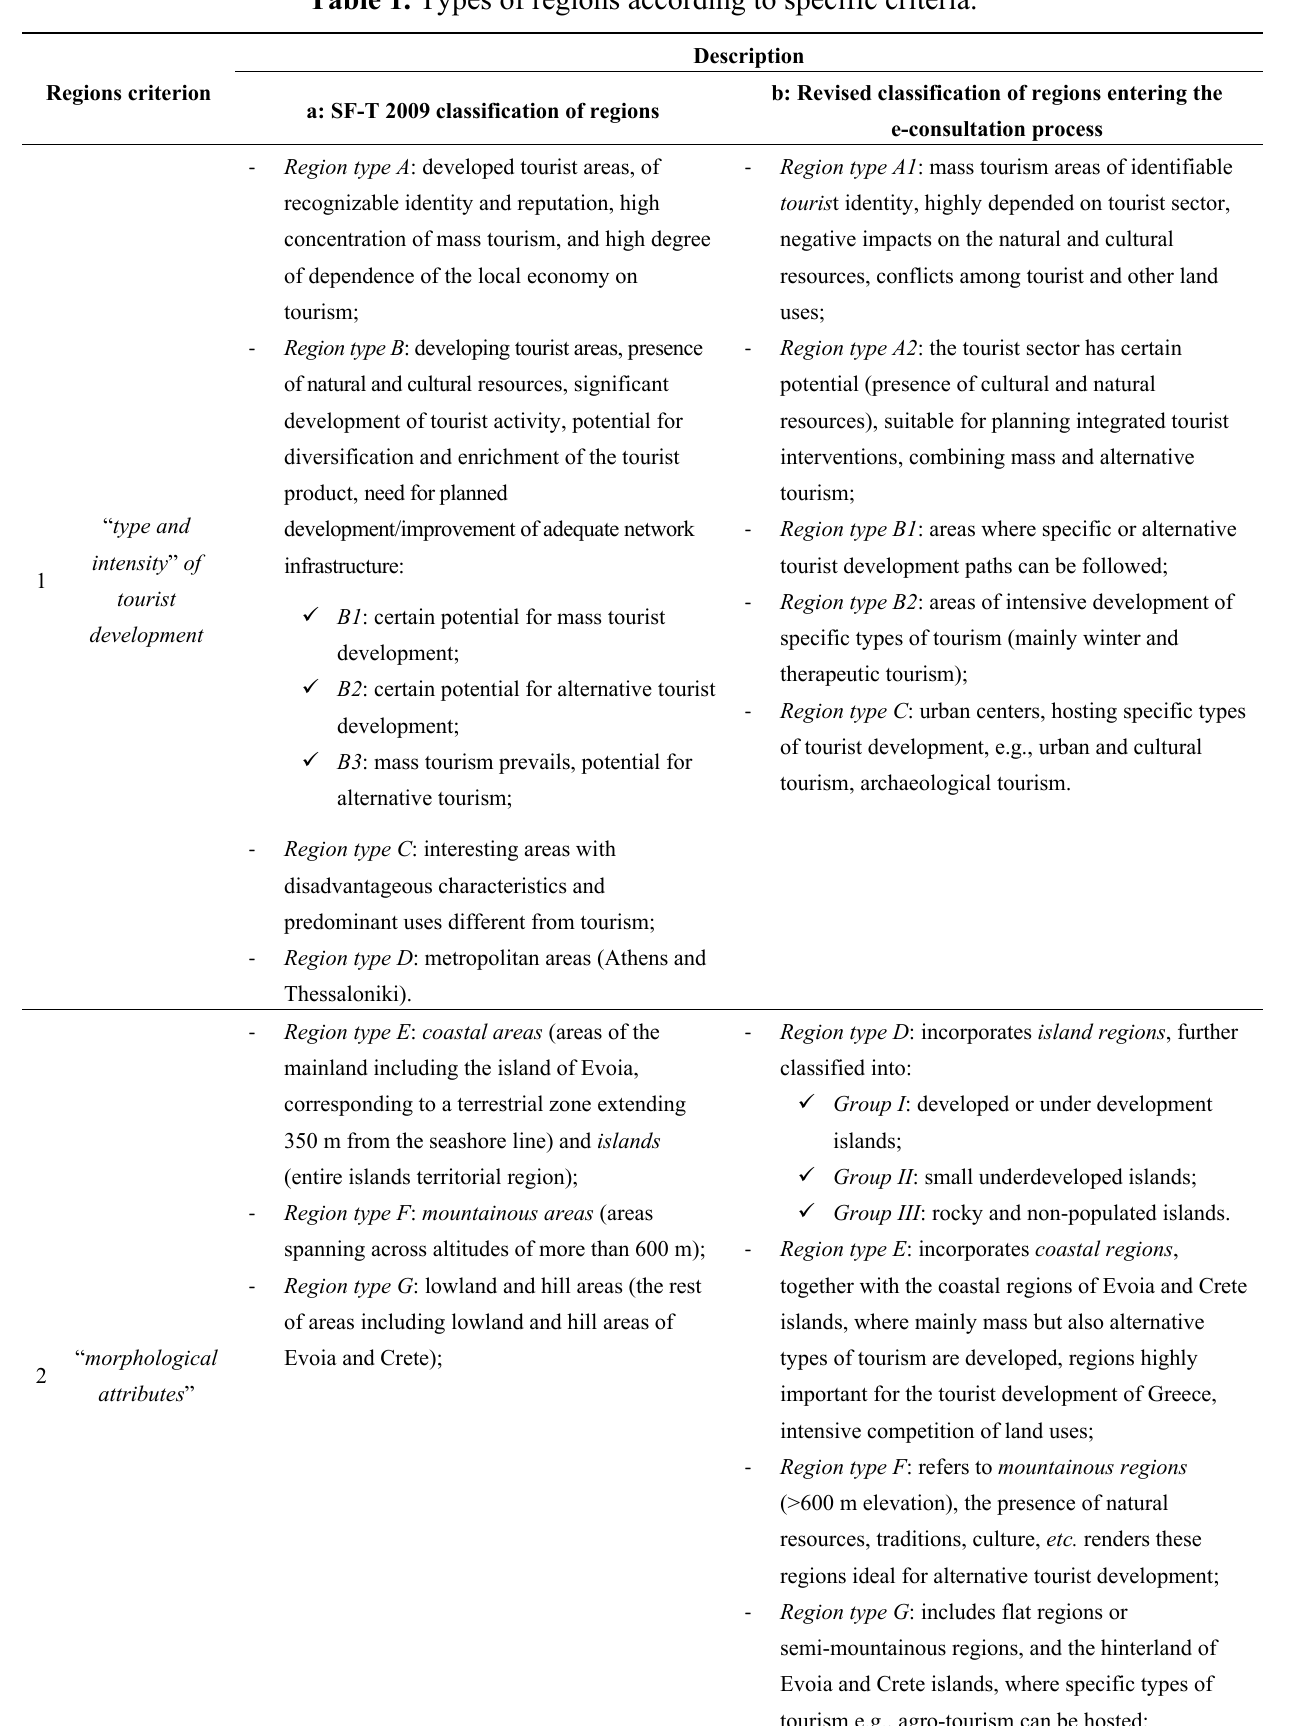
Table 1. Types of regions according to specific